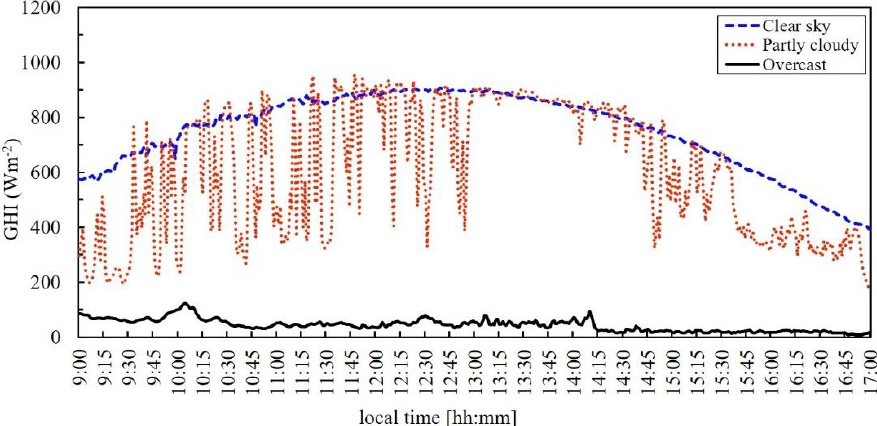
Figure 4. The variability of GHI measurement for clear-sky day (8 June 2020), partly cloudy day (4 June 2020), and overcast day (24 June 2020).